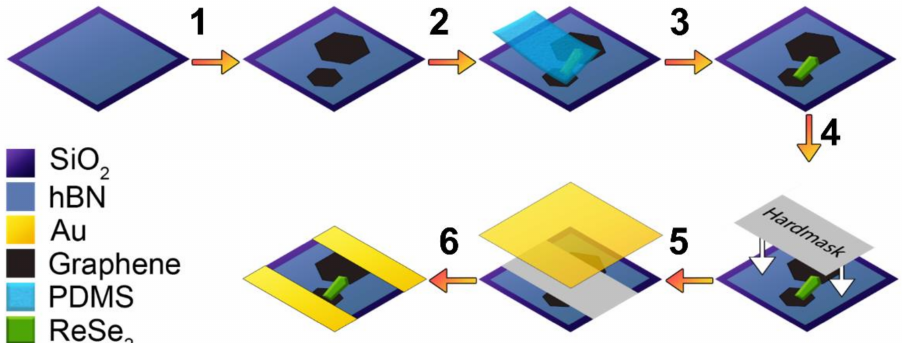
Figure 2. Schematic of the hBN/GSC/ReSe 2 device production process: (1) transfer of GSC to a Si/SiO 2 /hBN substrate, (2–3) placement of the exfoliated ReSe 2 crystal across two discrete GSCs by “pick & place” method, using a PDMS stamp, (4) placement of a glass shadow mask (125- µ m-thick) to form the mask for the metallic contacts, (5) Cr/Au layers sputtering, and (6) removal of the hard mask to form the Cr/Au